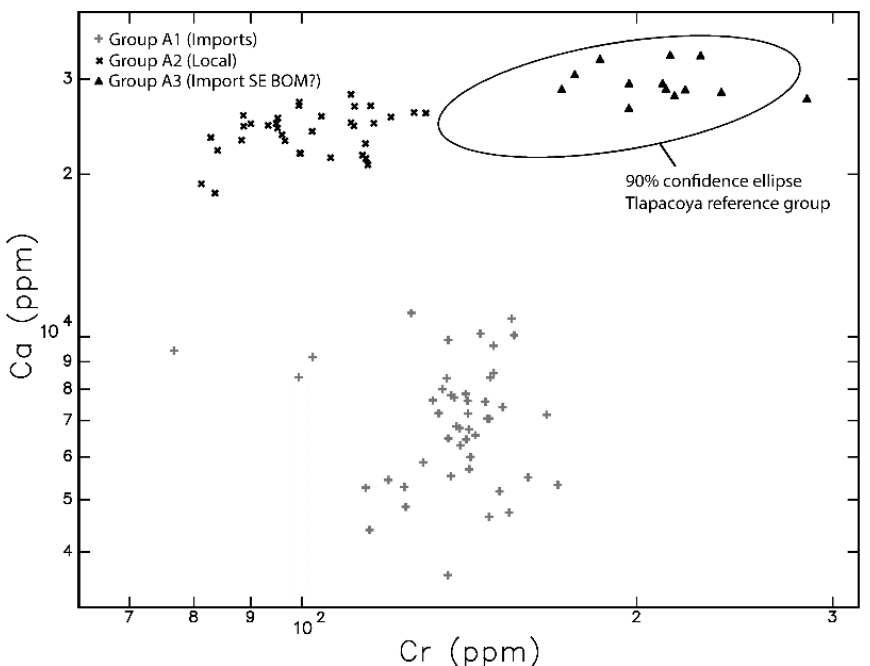
Figure 5. Altica chemical groups depicted on logged axes of chromium and calcium determined via bulk NAA data. The Tlapacoya reference group is depicted as a 90% confidence ellipse in the upper right corner of the plot. Table 1. Barium statistics in Altica and Tlapacoya reference groups and the sample in this study. Group